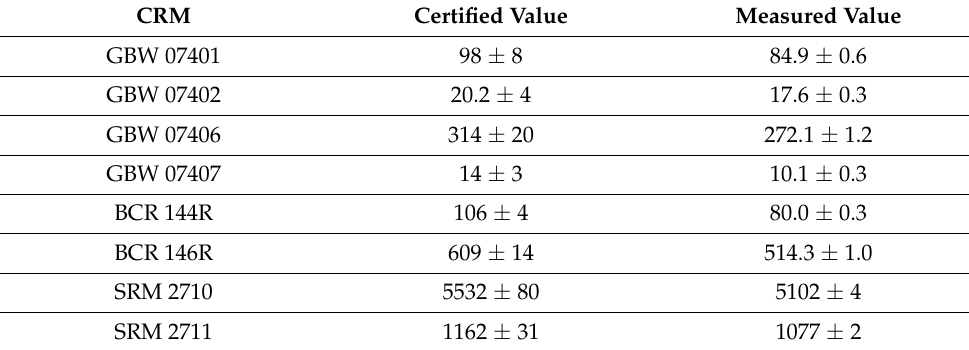
Table 1. Concentrations of Pb (mg/kg) in the tested certified reference